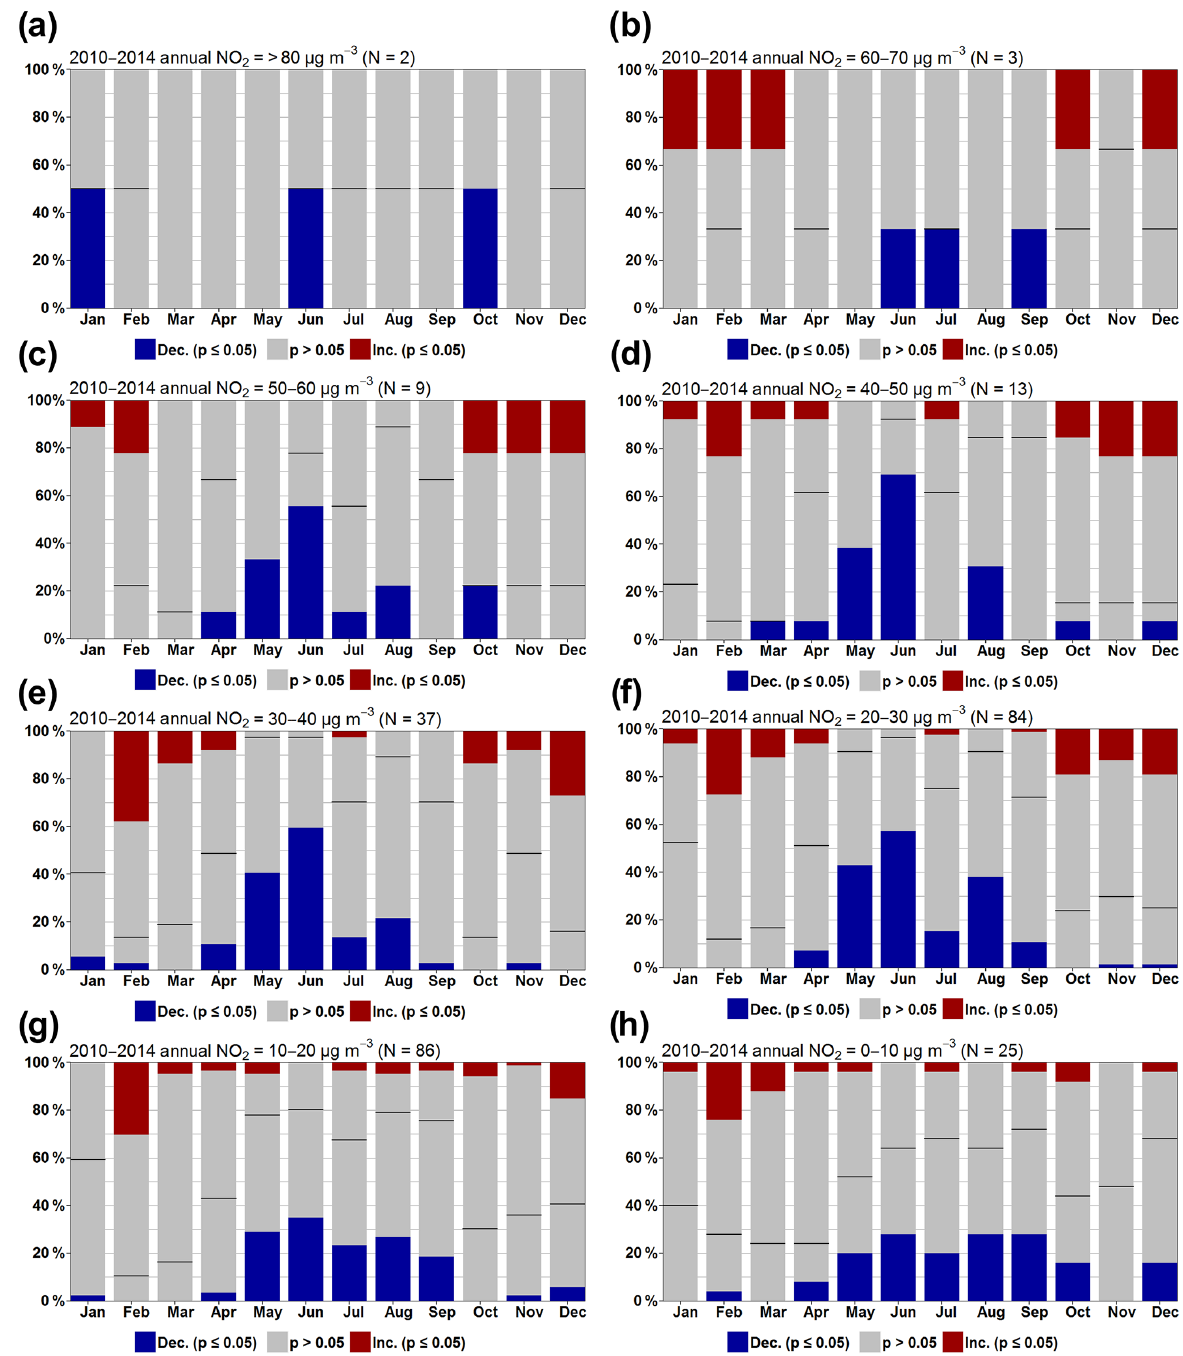
Figure 10. Proportion of sites with significant decreasing (blue), increasing (red) ( p ≤ 0.05), and non-significant (grey) trends in the monthly percentage contribution to annual average NO 2 between 2000 and 2014, for sites with 2010–2014 average annual NO 2 concen- trations (NO 2AA ) of (a) >80µgm − 3 , (b) 60–70µgm − 3 , (c) 50-60µgm − 3 , (d) 40–50µgm − 3 , (e) 30–40µgm − 3 , (f) 20–30µgm − 3 , (g) 10– 20µgm − 3 , and (h) 0–10µgm − 3 . Trend estimates were calculated using a first-order autoregressive (AR(1)) model. The black line represents the division between decreasing and increasing trends within the non-significant